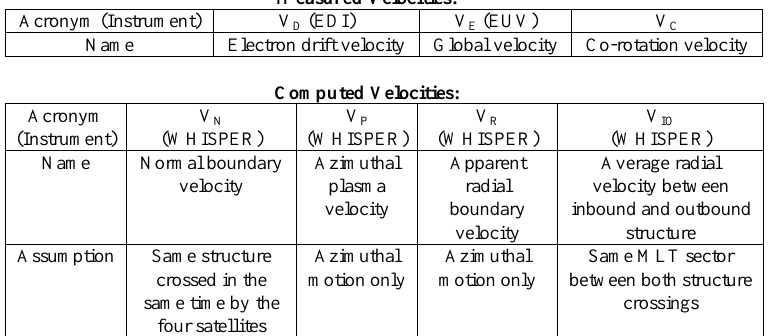
Table 1. Summary of the different types of velocity. Measured Velocities: Acronym (Instrument) V D (EDI) V E (EUV) V C Name Electron drift